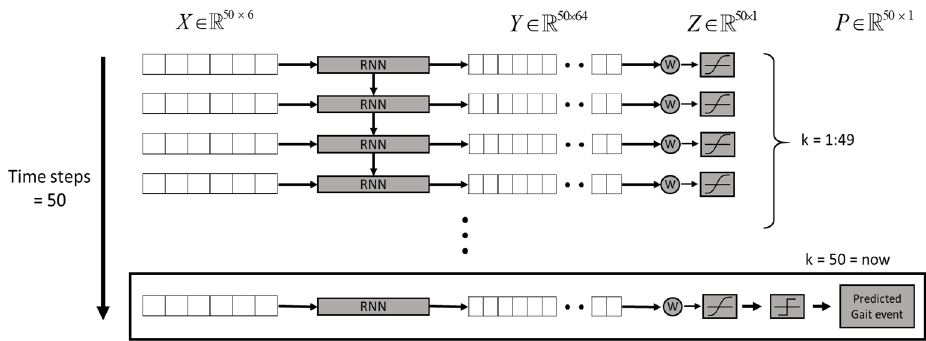
Figure 4. The RNN model for HS detection [24].